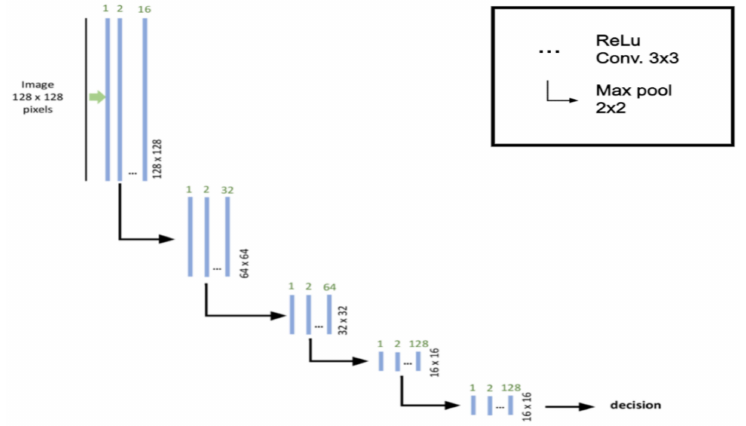
Figure 2. Analysis of the CNN U-Net used. Each blue box corresponds to a multi-channel feature map. The number of channels is denoted on top of the box. The x-y-size is provided at the lower left edge of the box [22].